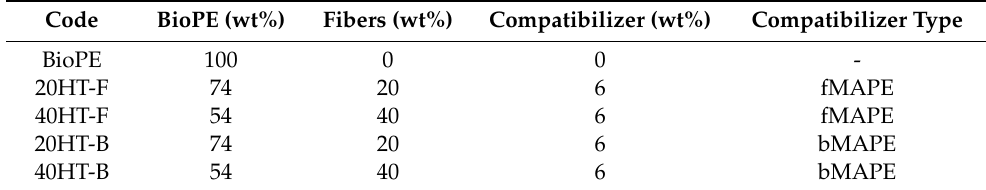
Table 5. Biocomposites